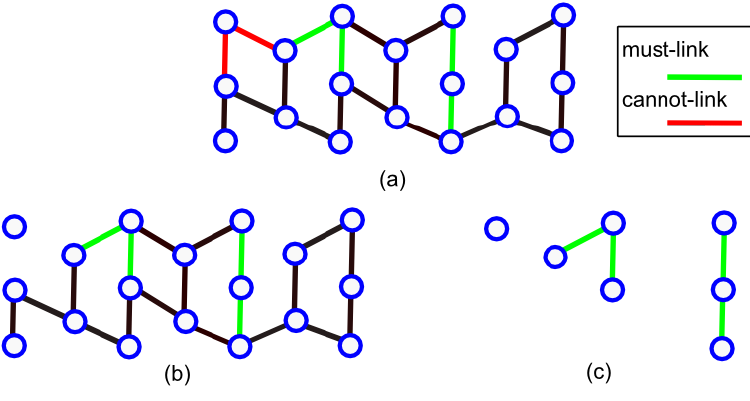
Figure 5. Cut process : ( a ) k -NN graph before Cut ; ( b ) k -NN graph after Cut ; and ( c ) discrete